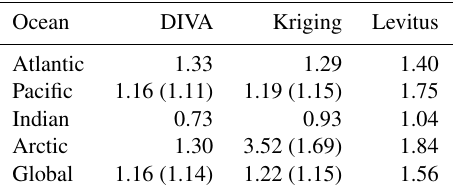
Figure 2. Absolute difference between the analyzed (using the DIVA method, Troupin et al., 2012) and unanalyzed (from the World Ocean Atlas 1998, WOA, 1998) annual-mean temperature at a depth of 10m, shown as contour lines (for the contour inter- vals, see the color bar). In addition, the MARGO ocean sediment core sites are depicted as black circles (MARGO Project Members, 2009). Table 1. Root-mean square annual-mean NSST differences be- tween the interpolated and observed fields at all WOA (1998) un- analyzed data locations, binned into 2 ◦ longitude–latitude squares for the different oceans and three different interpolation methods. Differences in parentheses arise if all NSST values below − 1 . 8 ◦ C (taken as the freezing point) are set to this value in the analyzed